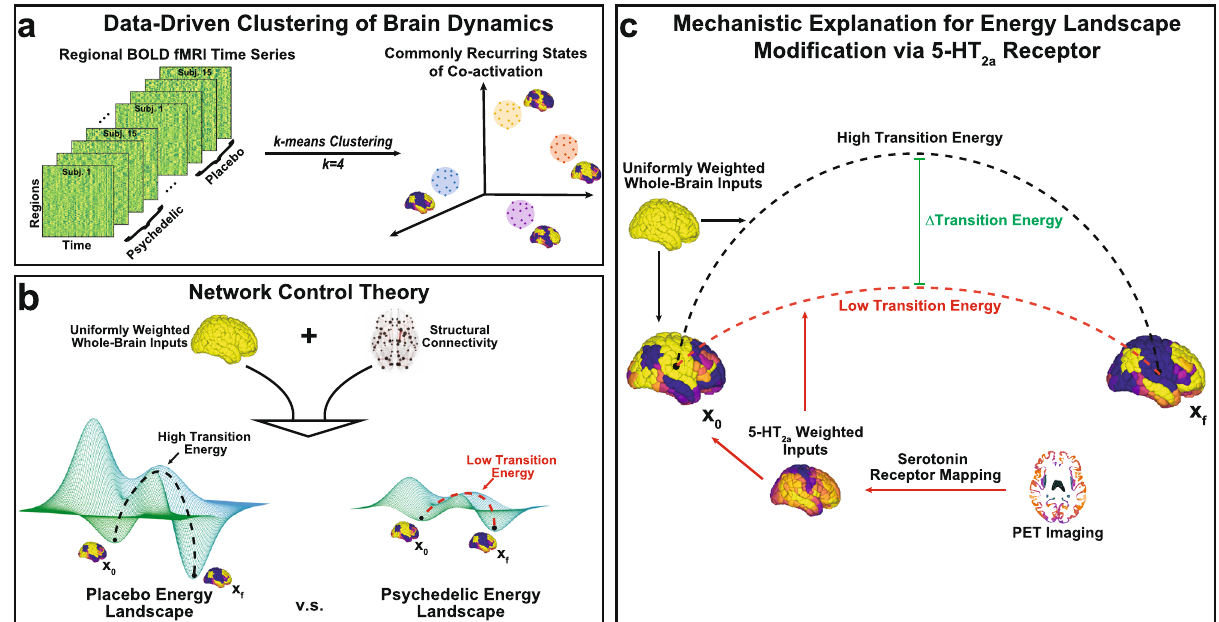
Fig.1|Mappingtheenergylandscapeofthehumanbrainwithnetworkcontrol theory. a We concatenated all fMRI time series together (all subjects, all condi- tions) and employed the k -means clustering algorithm to identify common acti- vation patterns, or states. b Using network control theory and a representative structuralconnectome 34 ,wecalculatedtheminimumenergyrequiredtotransition between states (or maintain the same state) using each individual ’ s brain states